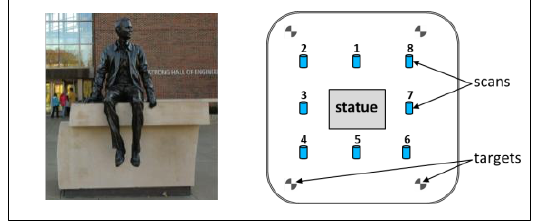
Figure 3. Left: View of Neil Armstrong Statue at Purdue University, from Scan#1. Right: Layout of scans and